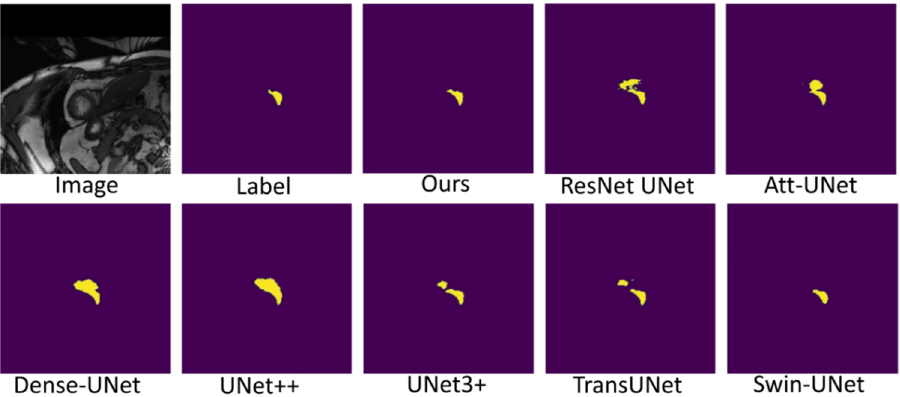
Figure 7. Comparison of right ventricle (RV) segmentation results.